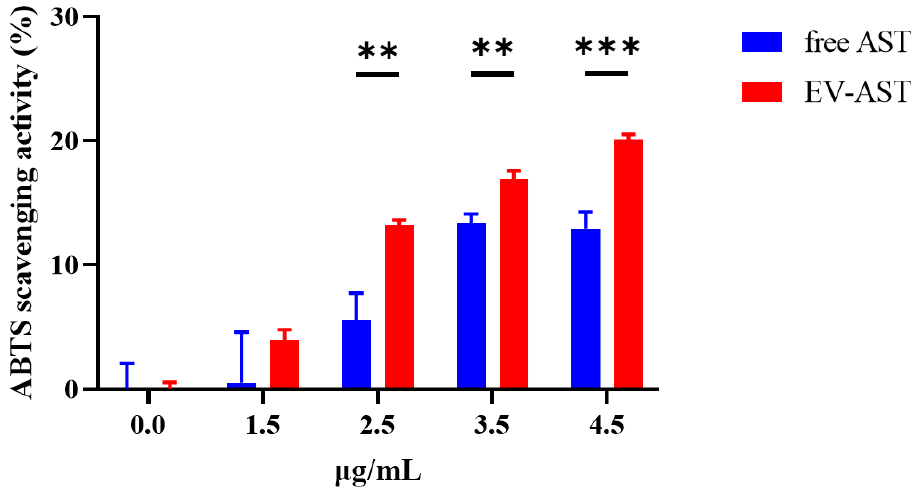
Figure 4. ABTS radical scavenging activity (%) of free AST and EV-AST at concentrations of 0, 0.5, 1.5, 2.5, 3.5, 4.5, and 5 µ g/mL (**: p < 0.01; ***: p < 0.001).